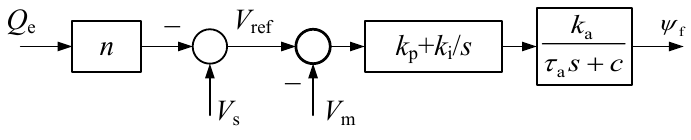
Figure 3. Flux control